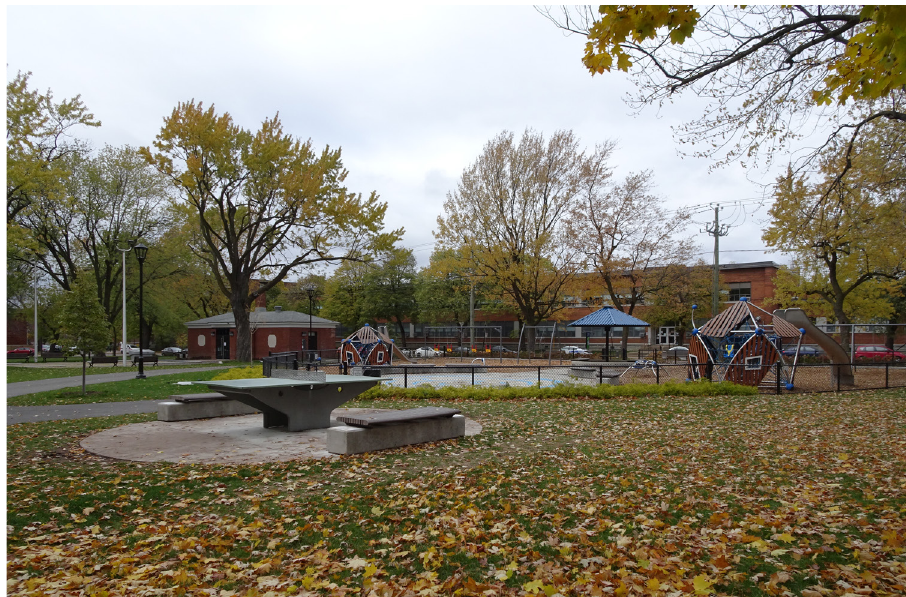
Fig. 1. Parc de l'Ukraine after the replanning.